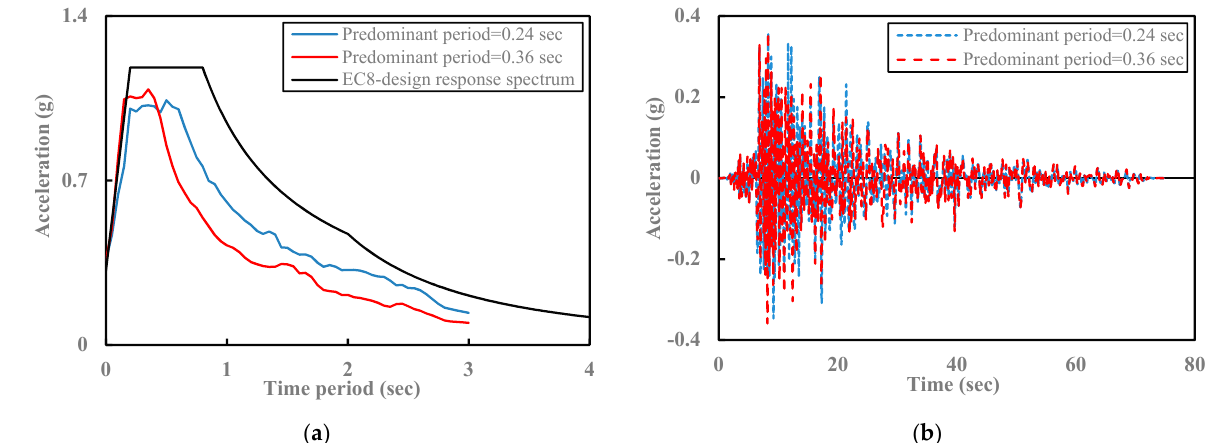
Figure 2. Comparison of the real and design earthquake input data including ( a ) the design response spectrum and ( b ) the acceleration time histories.